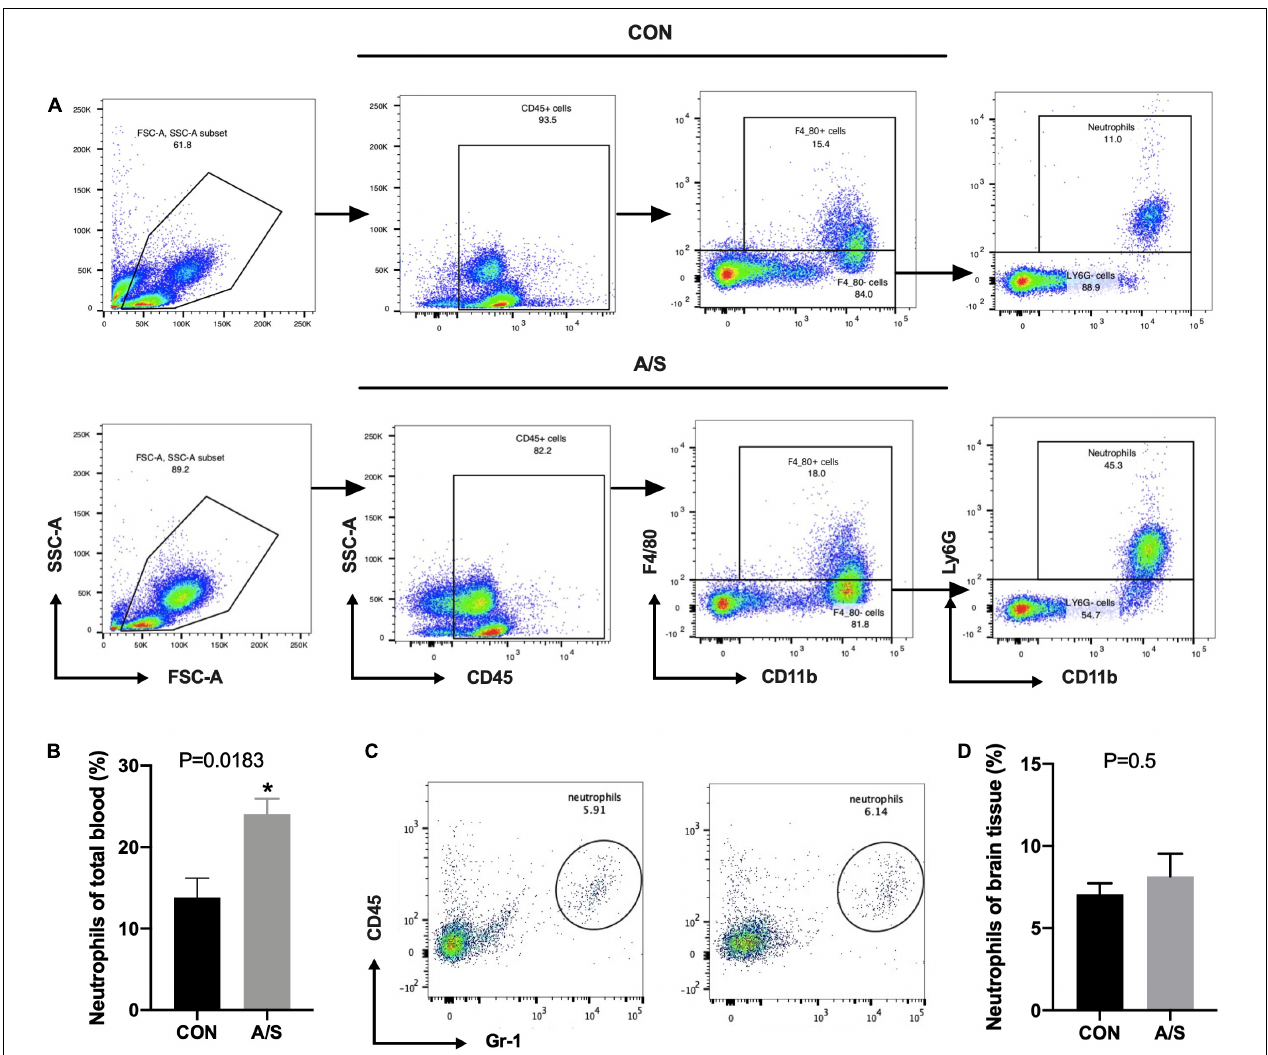
FIGURE 2 | Neutrophils in peripheral blood but not brain increased significantly after anesthesia/surgery. (A) Representative flow cytometry plots show the gating strategy of neutrophils (CD45 + CD11b + F4/80 − Ly6G + ) in peripheral blood. (B) The percentage of neutrophils increased significantly 24 h after anesthesia/surgery, P = 0.0183. (C,D) There was no significance of neutrophils proportion in brain between CON and A/S groups, P = 0.5. Data are expressed as mean ± SE ( n = 3–4 per group). * P < 0.05 compared with that of the control group.